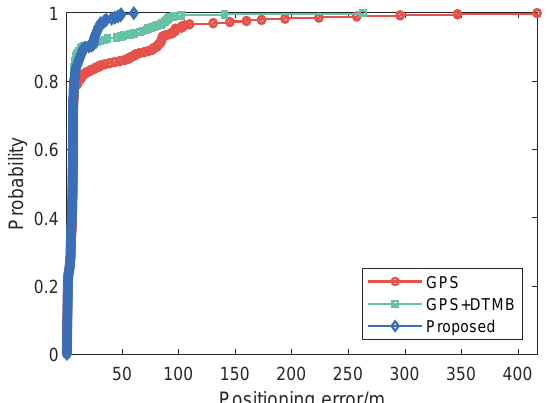
Figure 24. Empirical CDF curves of GPS-only, GPS + DTMB and the proposed method at Site 2.